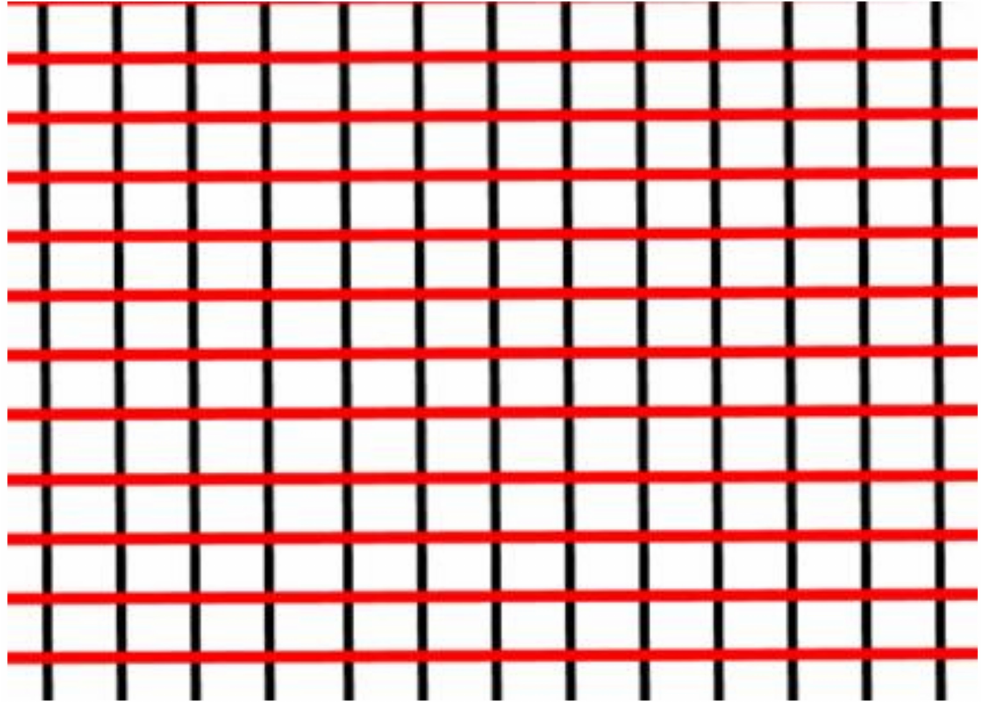
Figure 3. The woven fabrics are composed of weft yarns (illustrated in red) and warp yarns (illustrated in